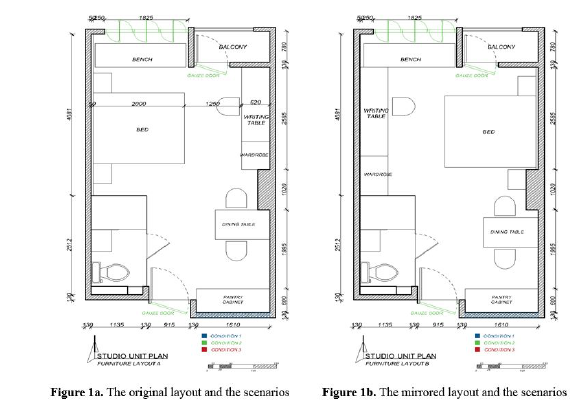
Fig. 1. Condition for